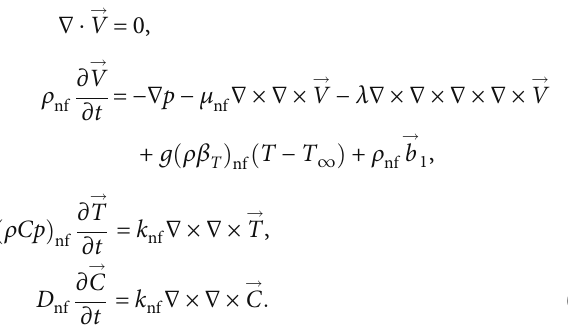
Figure 1: Geometry of the fl